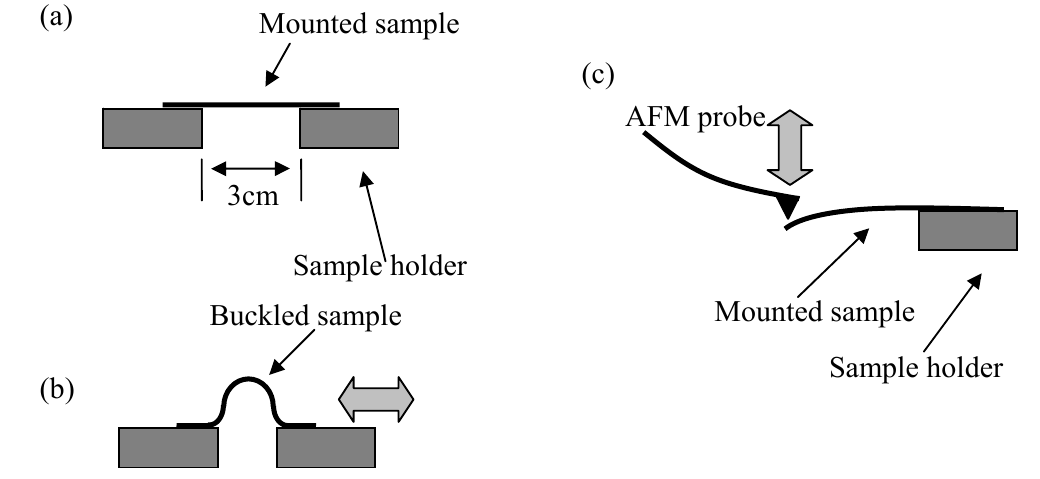
Figure 2. Simple diagrams of Motorized Linear Stage (MLS) (a and b) and AFM setup (c) to apply mechanical stresses on a